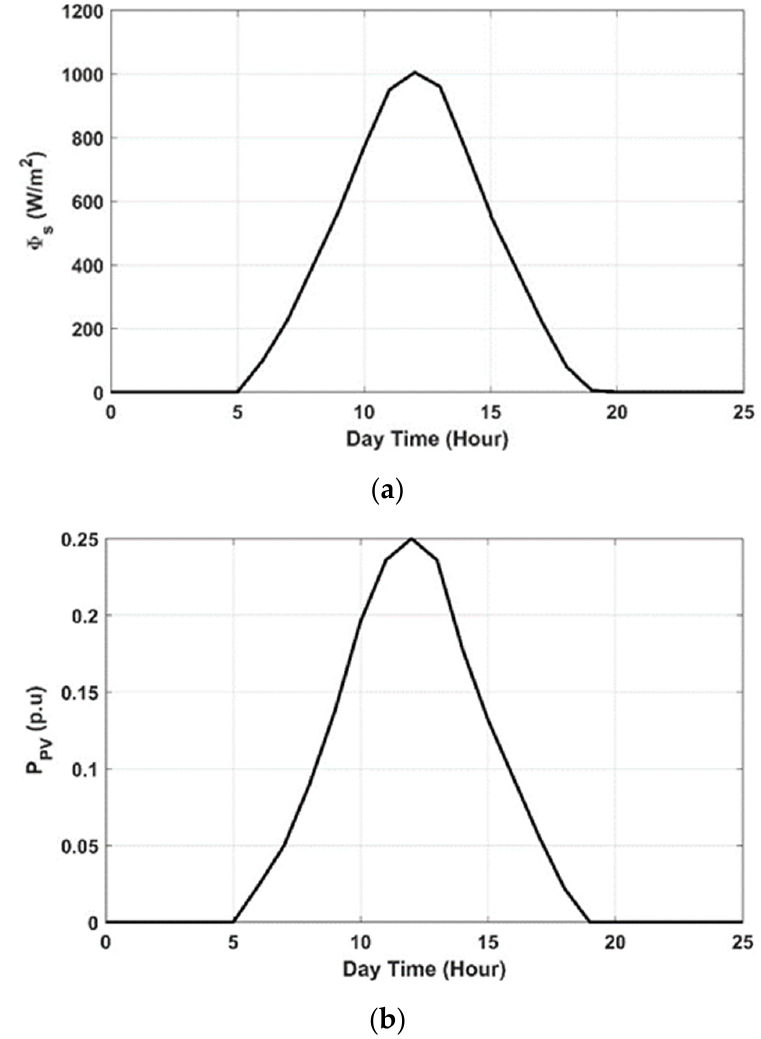
Figure 2. ( a ) Daily solar radiation and ( b ) PV output power.